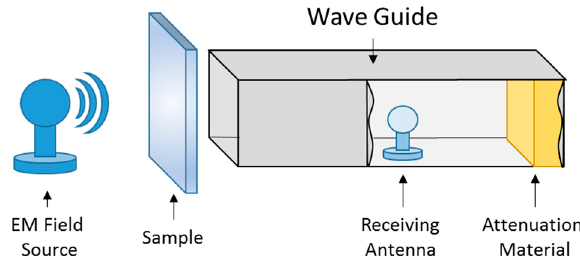
Figure 4. Schematic diagram of waveguide method set up.